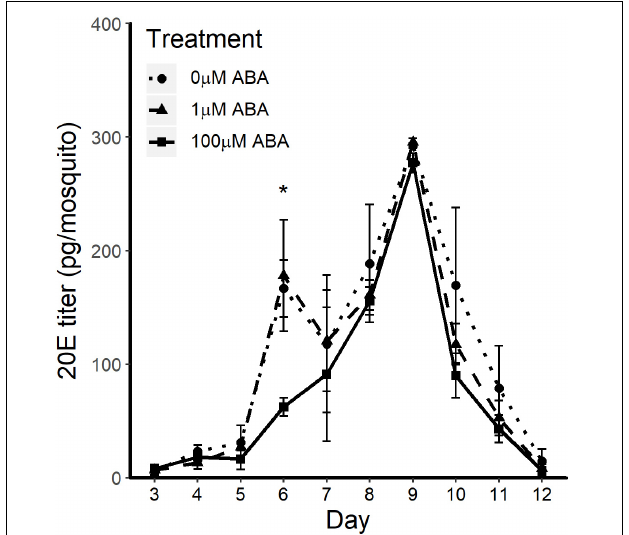
FIGURE 2 | ABA treatment effects on 20E titers through larval development (days 1–7), during the pupal stage (days 8–9) and in newly emerged adult female A. stephensi (day 10) were minimal to undetectable. 20-hydroxyecdysone (20E) titers were measured from 20 to 40 individuals each day starting with second instar larvae from 3 days post-egg hatch through to 8 h post-eclosion of adult female mosquitoes. Larval exposure to 100 µ M ABA reduced 20E titers on day 6 of larval development relative to controls ( t -test p = 0.017), but no other differences were observed. Each biological sample was analyzed in triplicate to confirm assay reproducibility. Data from three biological replicates were combined for analysis and are shown as mean ±